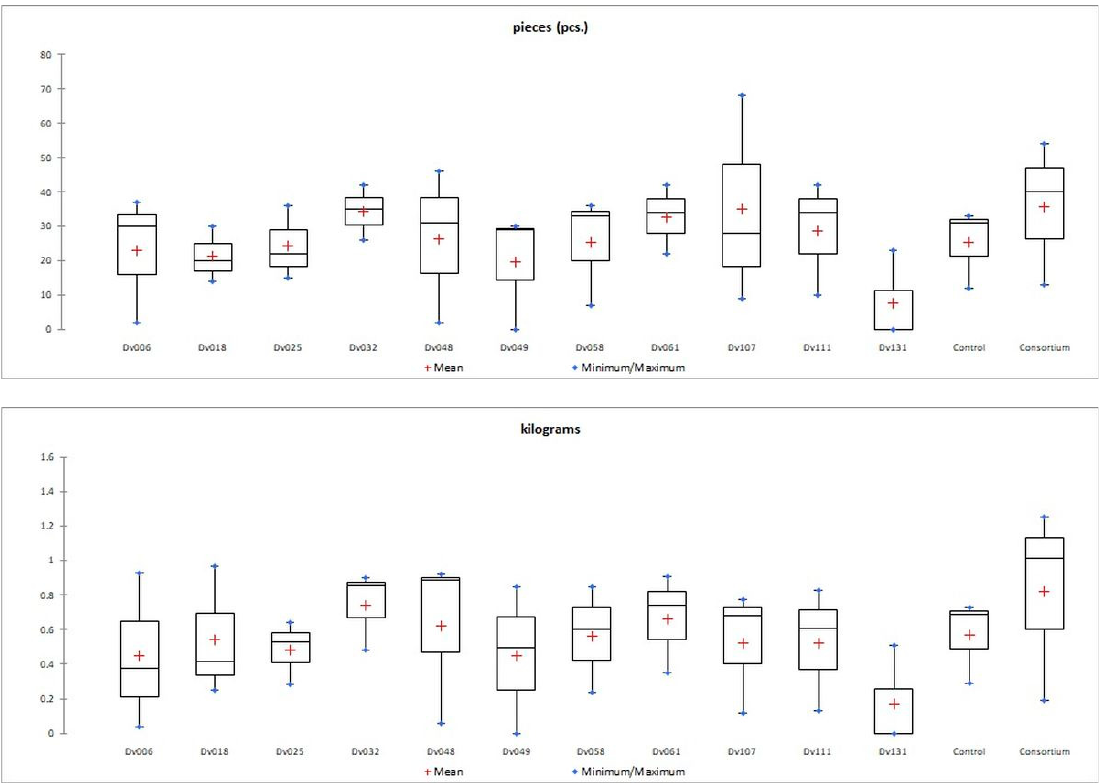
Figure 2. Graphical presentation (box-plot) of the distribution of a statistical feature of quantity (pieces) and mass (kilograms) of tomato fruit yield in each treatment.